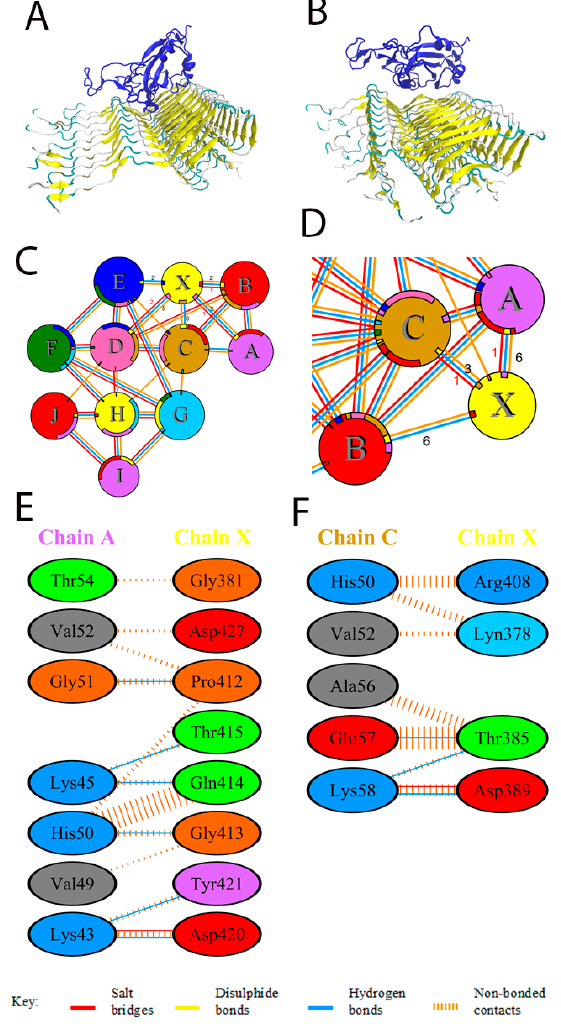
Figure 2. Interaction of SARS-CoV-2 RBD with the oligomer of alpha-synuclein by docking ( left ) or after 200 ns of molecular dynamics ( right ). Chains from A to I correspond to alpha-synuclein; chain X corresponds to RBD. ( A , C ) General view of binding and scheme of interactions according to docking results. Alpha-synuclein is colored yellow; RBD is colored blue. ( A , B ) General view. ( C , D ) Schematic representation of the interaction of RBD with alpha-synuclein after molecular dynamics. ( E , F ) Residues with the most significant contribution to the binding according to calculations. ( left ) docking; ( right ) molecular